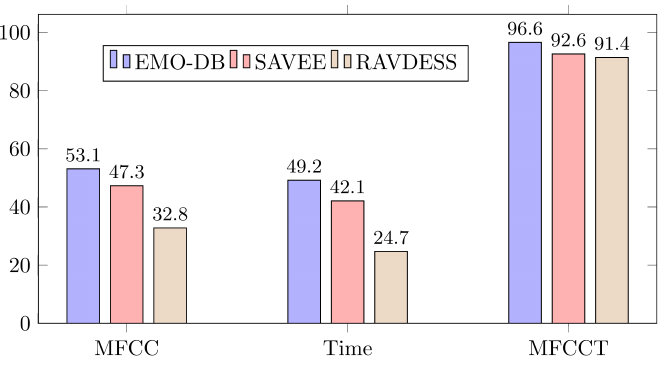
Figure 6. Performance comparison of MFCC, t-domain, and MFCCT.